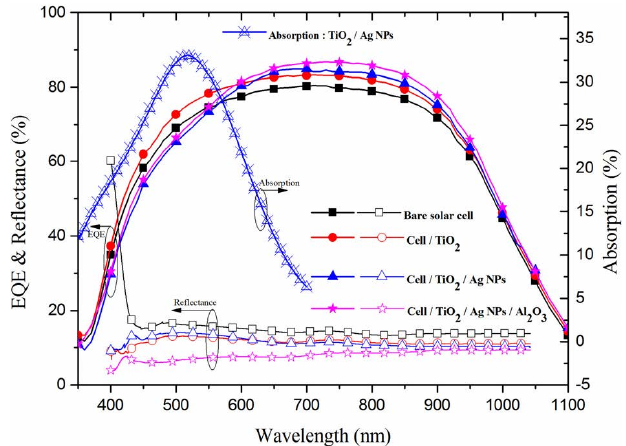
Figure 6. External quantum efficiency (EQE) response of bare textured c-Si solar cell, cell with TiO 2 spacer layer, cell with double layer of TiO 2 /Al 2 O 3 , cell with In-NPs on TiO 2 spacer layer, cell with Ag-NPs on TiO 2 spacer layer, cell with In-NPs embedded in TiO 2 /Al 2 O 3 , and cell with Ag-NPs embedded in TiO 2 /Al 2 O 3 .